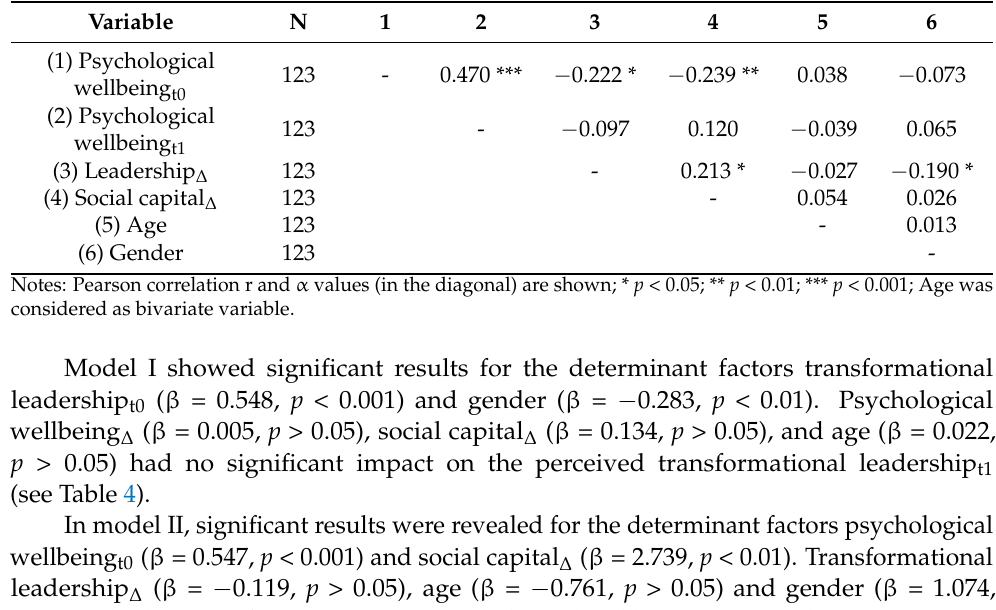
Table 3. Correlations between variables, model